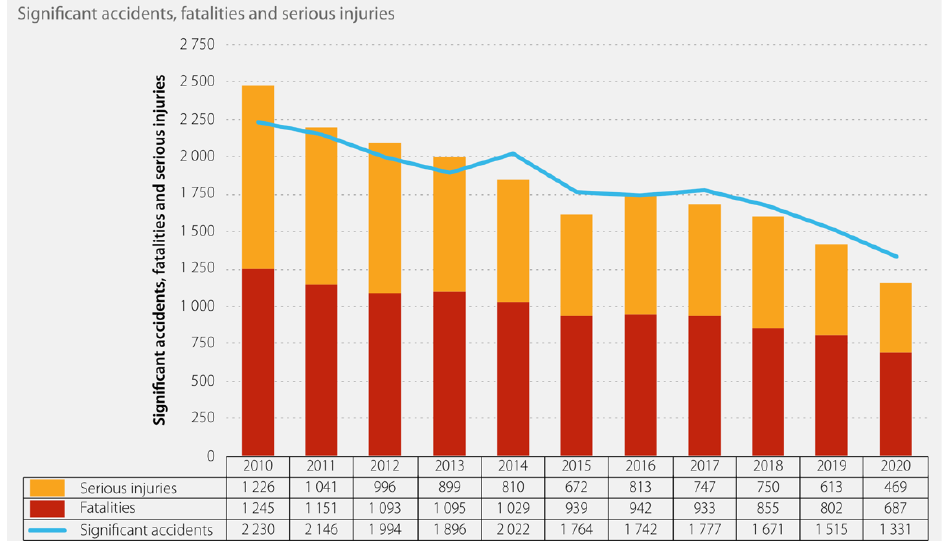
Figure 10. ERA 2022 Report on Safety and Interoperability